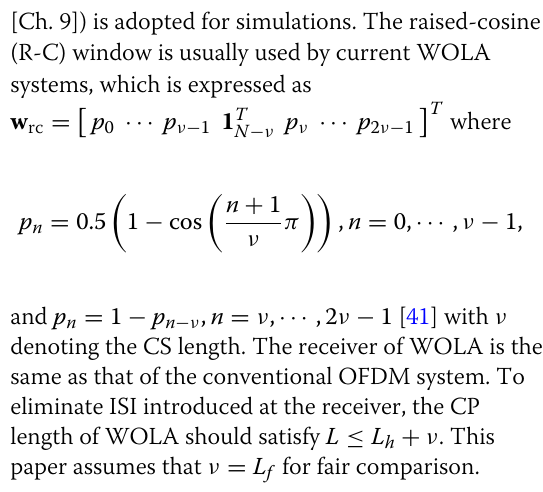
denoting the CS length. The receiver of WOLA is the same as that of the conventional OFDM system. To eliminate ISI introduced at the receiver, the CP length of WOLA should satisfy L ≤ L h + ν . This paper assumes that ν = L f for fair comparison.